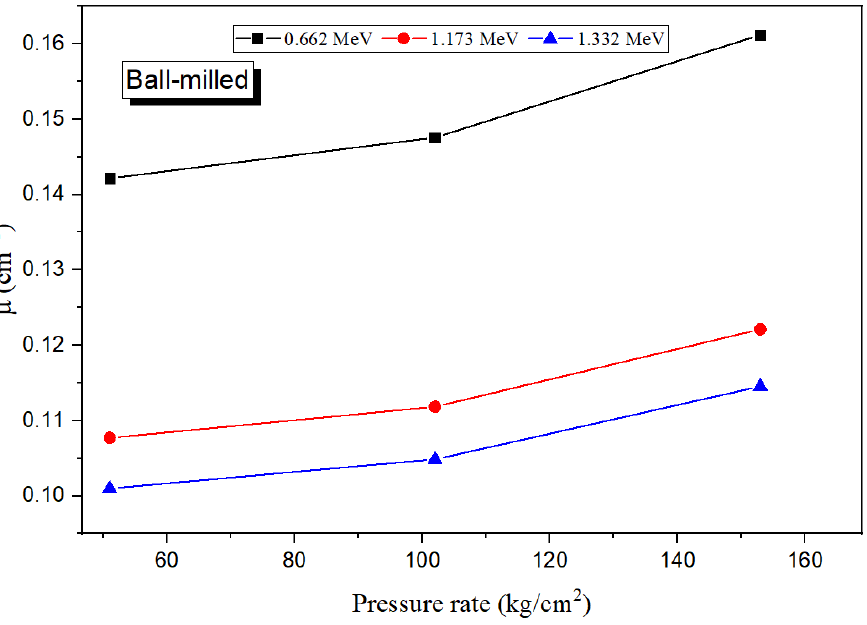
Figure 7. Variation in the LAC of the ball-milled bentonite as a function of the pressure rate (kg/cm 2 ).